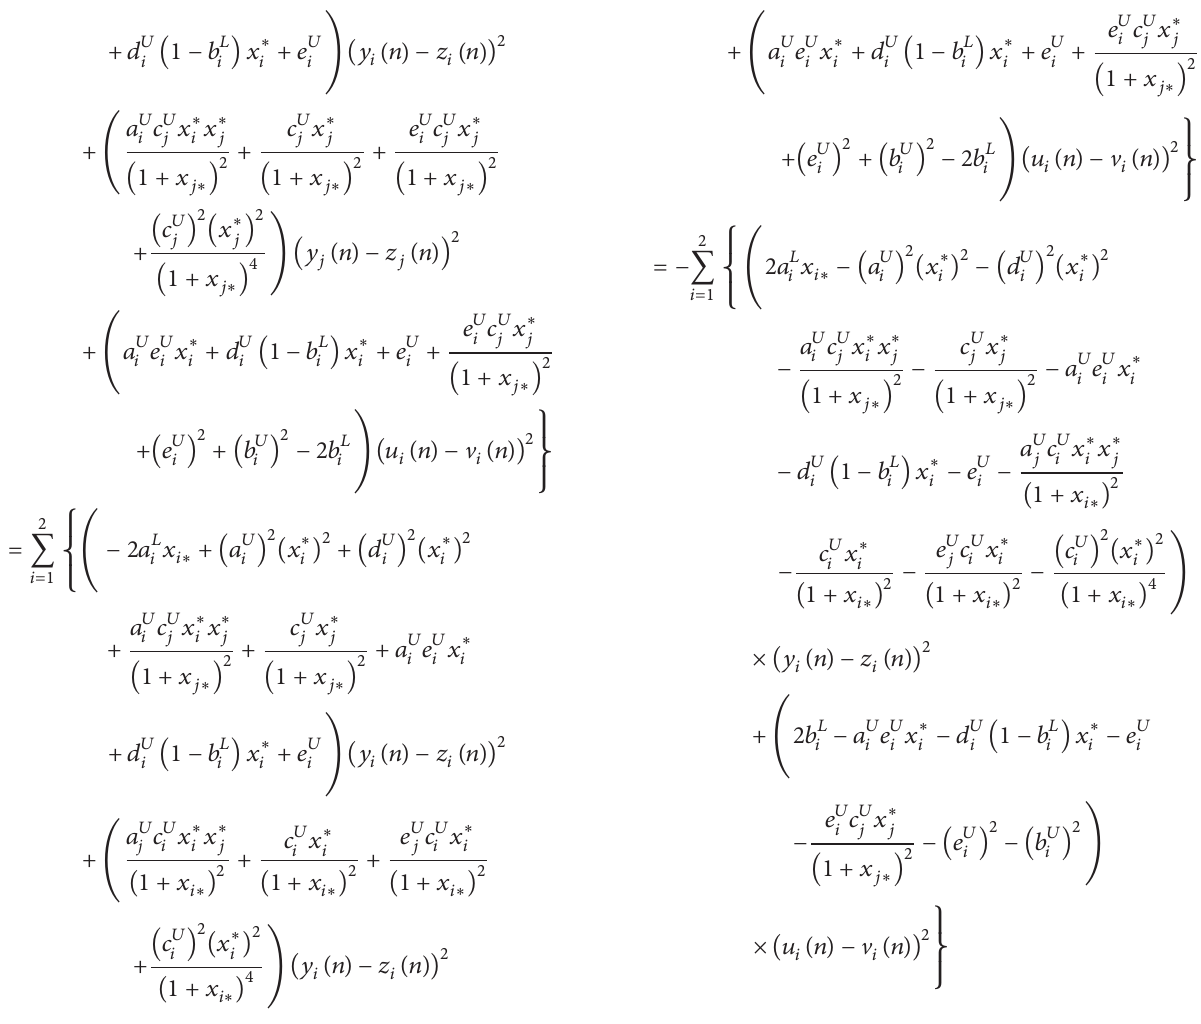
Figure 4: 2-dimensional phase portrait. (a) Phase portrait of 𝑥 ∗ 1 (𝑛) and 𝑥 ∗ 2 (𝑛) with initial values 𝑥 ∗ 1 (0) = 1.18, 𝑥 ∗ 2 (0) = 0.96 and 𝑥 1 (𝑛) and (𝑛) with initial values 𝑥 (0) = 1.06, 𝑥 (0) = 1.18 for 𝑛 ∈ [0, 100] , respectively. (b) Phase portrait of 𝑢 ∗ 𝑥 2 1 2 (0) = 0.024, 𝑢 ∗ (0) = 0.023 and 𝑢 (𝑛) and 𝑢 (𝑛) with initial values 𝑢 𝑢 ∗ 1 2 1 2